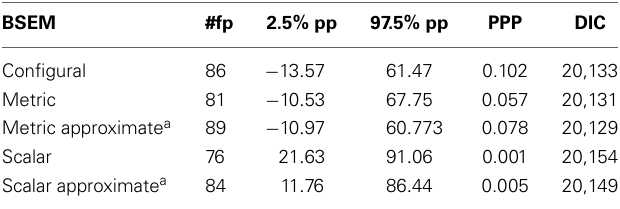
Table 4 | The measurement invariance analyses using Bayesian